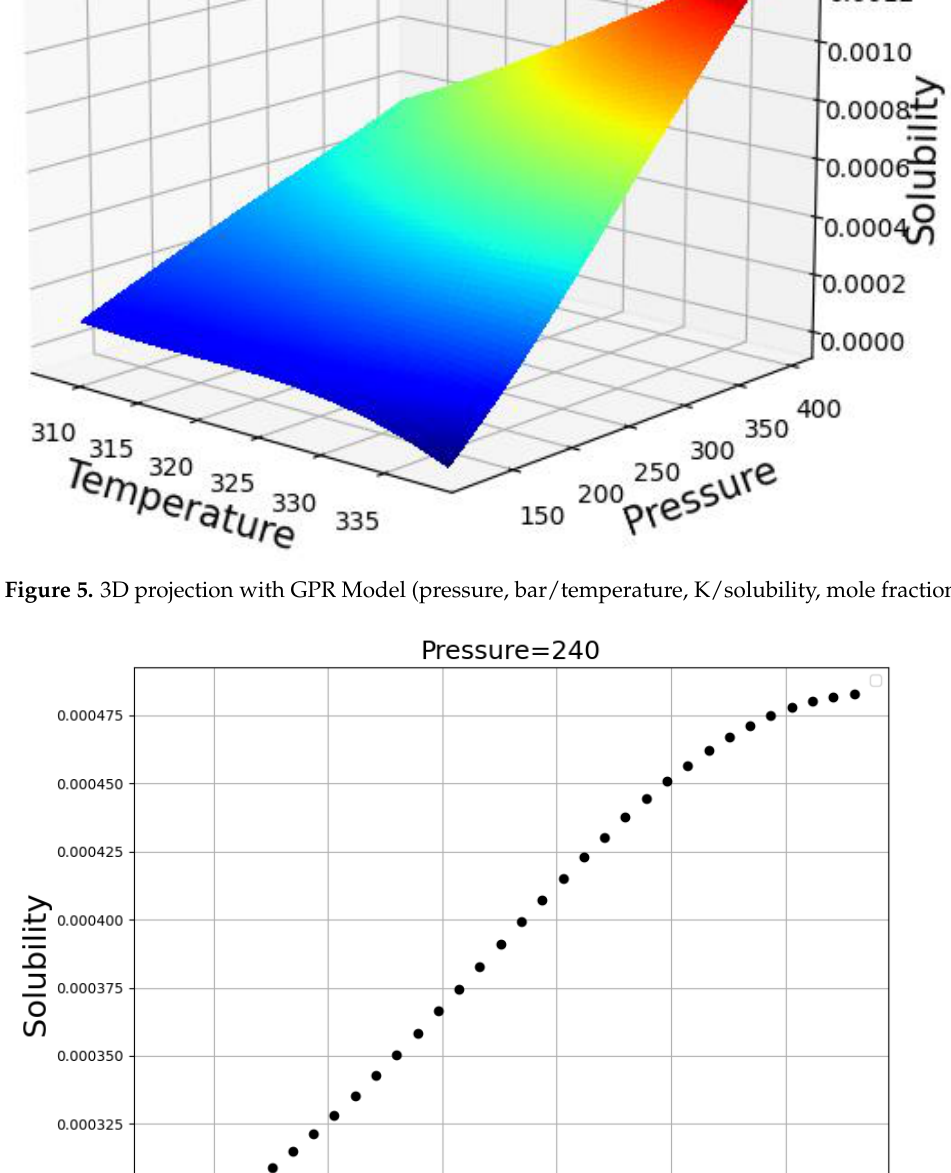
Figure 7. Trends for Pressure (bar). 5. Conclusions This paper was prominently focused on the prediction of oxaprozin solubility in SCCO 2 fluid. To do this, machine learning (ML) techniques were employed to develop mathematical modeling and simulations to predict and optimize drug solubility. To make models on the small dataset, three learning methods were chosen: MLP, KNN, and GPR. There are 32 data points in the dataset, each with two input parameters (temperature and